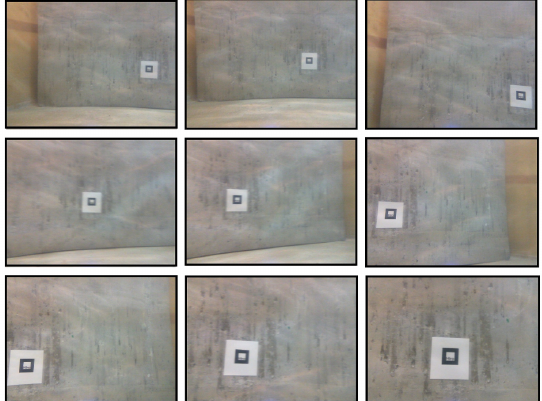
Figure 7. Camera view during the experiment. From initial view (top and left) to the final view (bottom and right). The target remains within the field of view of the